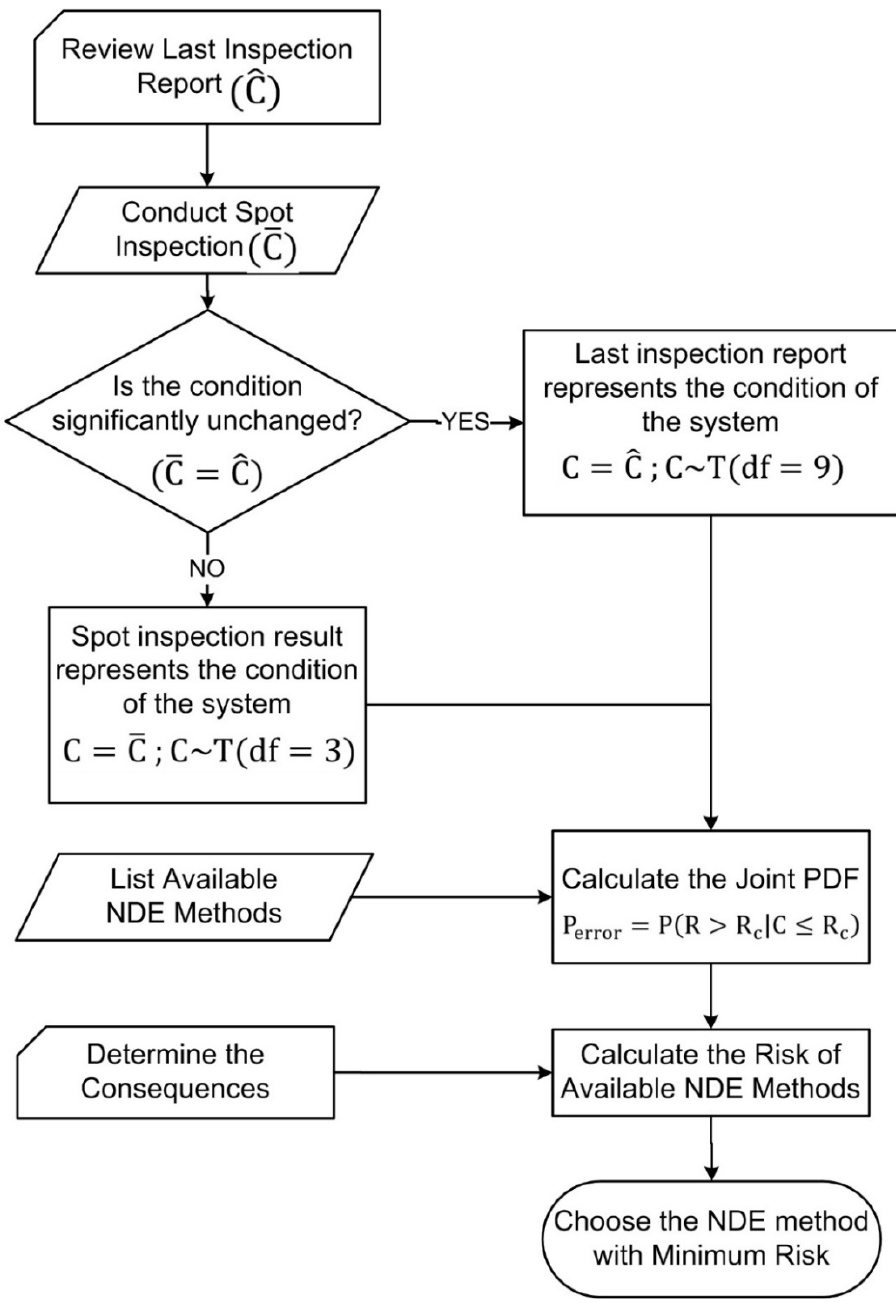
Figure 1. General procedure for risk-based selection of inspection method.